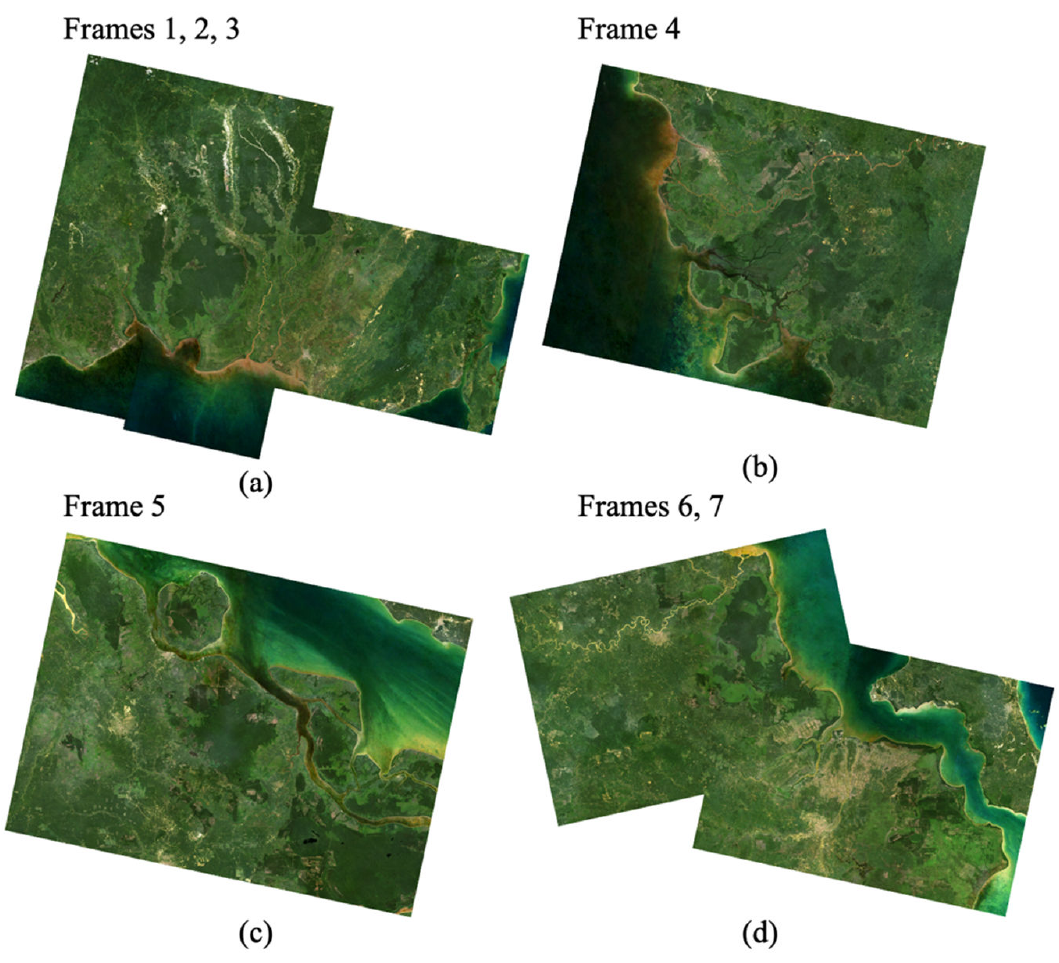
Figure 2. Landsat 8 true color images of each frame (RGB: bands 4, 3, and 2). ( a ) Frames 1, 2, and 3. ( b ) Frame 4. ( c ) Frame 5. ( d ) Frames 6 and 7.